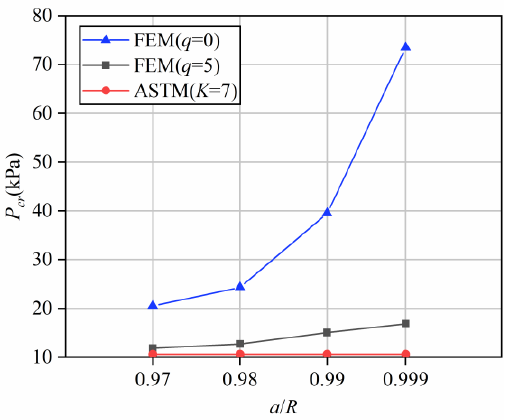
Figure 13. Comparing the influence of increasing a / R for critical buckling pressure under different q .